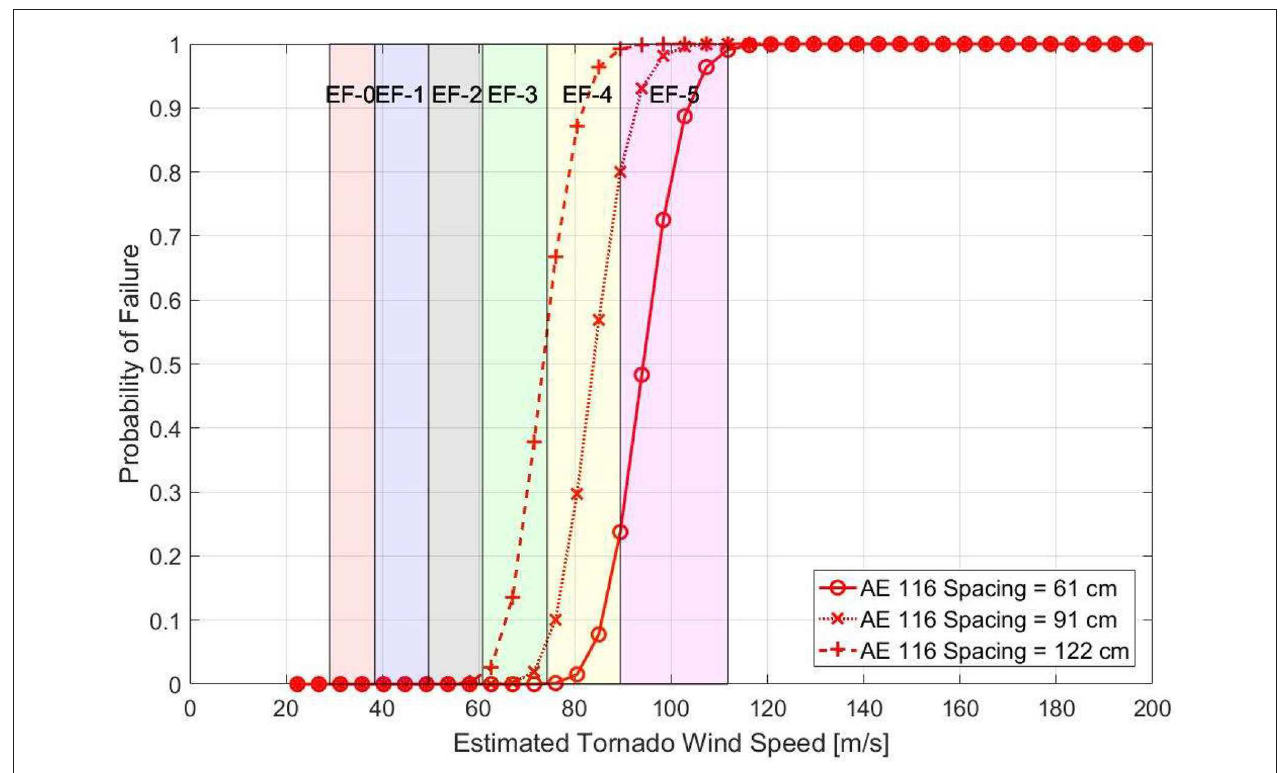
FIGURE 8 | Variation in performance based on change in spacing of bracket-type connections for structure